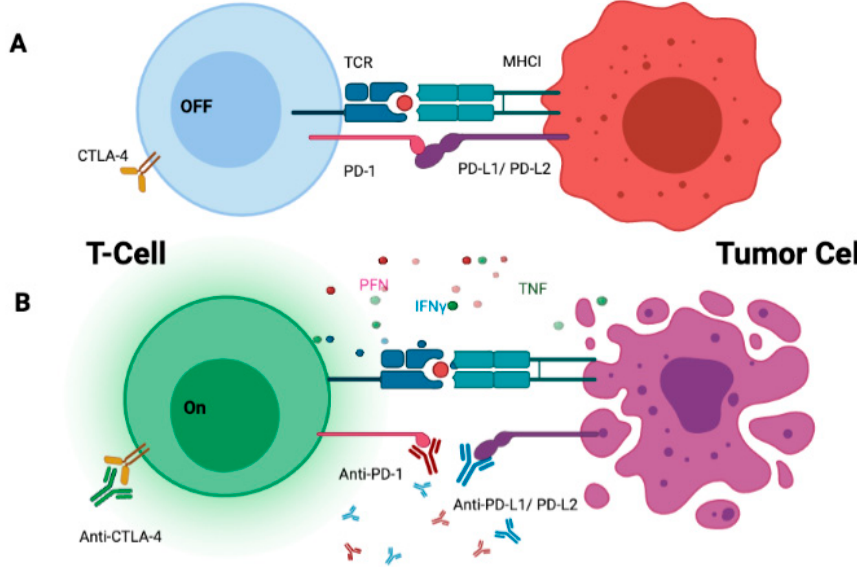
Figure 1. Schematic illustration of mechanism of action of PD-1, PD-L1, and CTLA4 checkpoint inhibitors. ( A ) The programmed cell death 1 (PD-1) receptor is expressed on sensitised immune cells (T cells in representation). Binding of PD-1 to its B7 family of ligands, programmed death ligand 1 (PD-L1) or PD-L2 results in the suppression of antigen-specific T-cell immunologic responses. Similarly, CTLA4 (cytotoxic T-lymphocyte-associated protein 4), is a protein receptor that functions as an immune checkpoint and downregulates immune responses. ( B ) Antibody blockade of